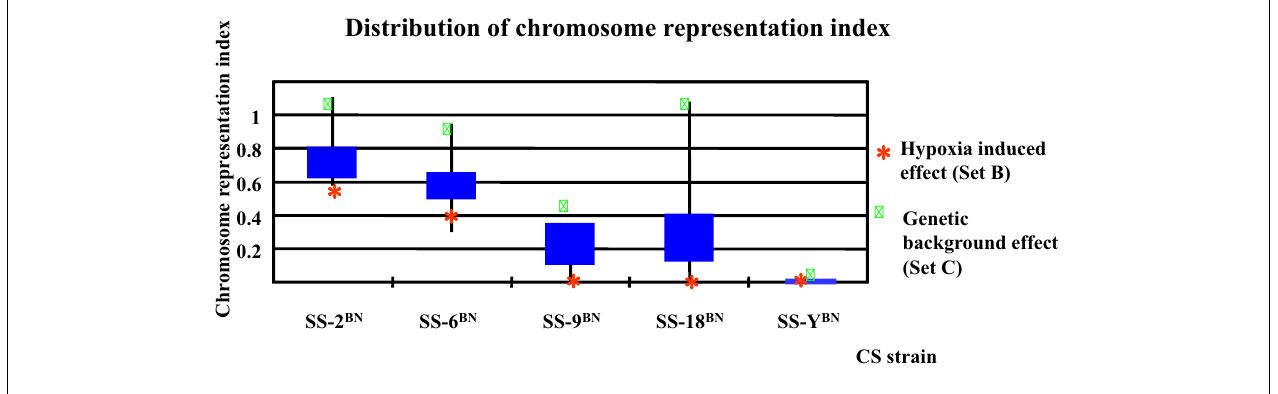
effect) are located at the lower quartile, whereas that of the Set C genes are of upper quartile, indicating a possible cis-effect in the genetic background induced transcription alterations, but a prevalence of trans-effect in hypoxia